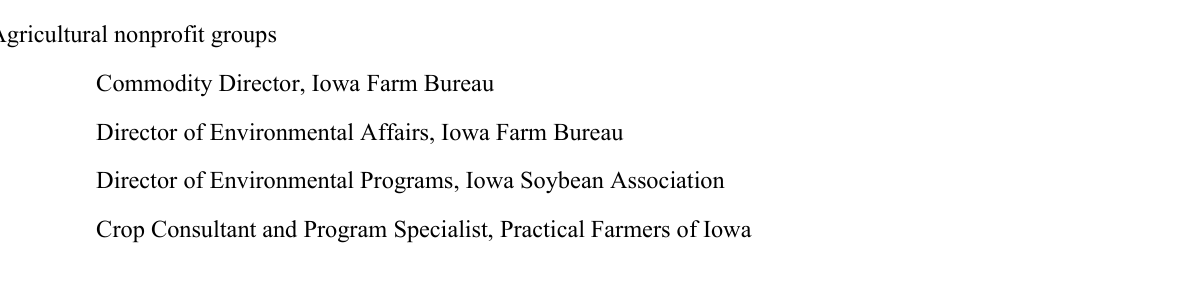
Table 1. Workshop participants represented the following